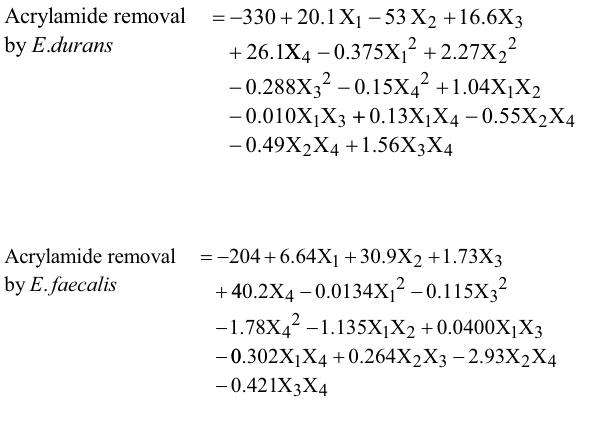
Figure 2G E. faecalis indicates higher acrylamide removal than E. durans under the same conditions as in Figure 2A. E. faecalis